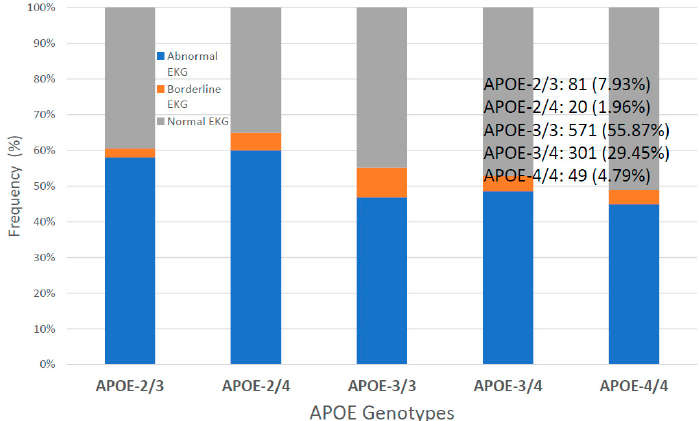
Figure 10. SIRT2 (rs10410544)-related electrocardiographic (EKG) pattern in Alzheimer’s disease.